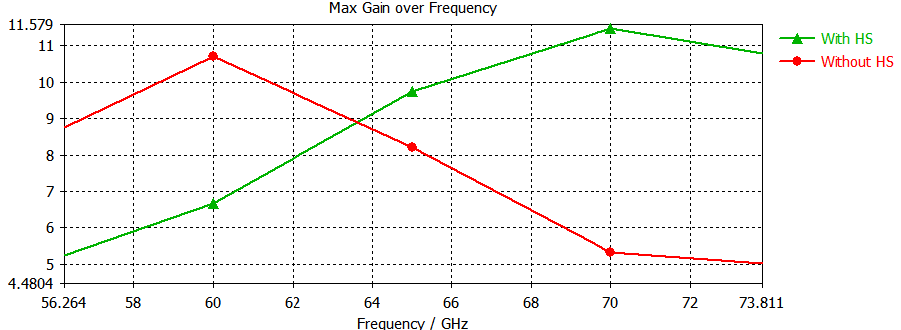
Figure 5. Comparison of with heterogeneous substrate and without heterogenous substrate in terms of frequency and gain.